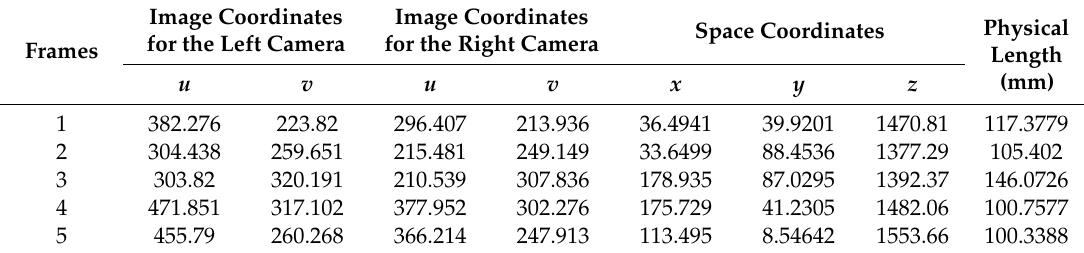
Table 5. Binocular vision measurements from group 2.